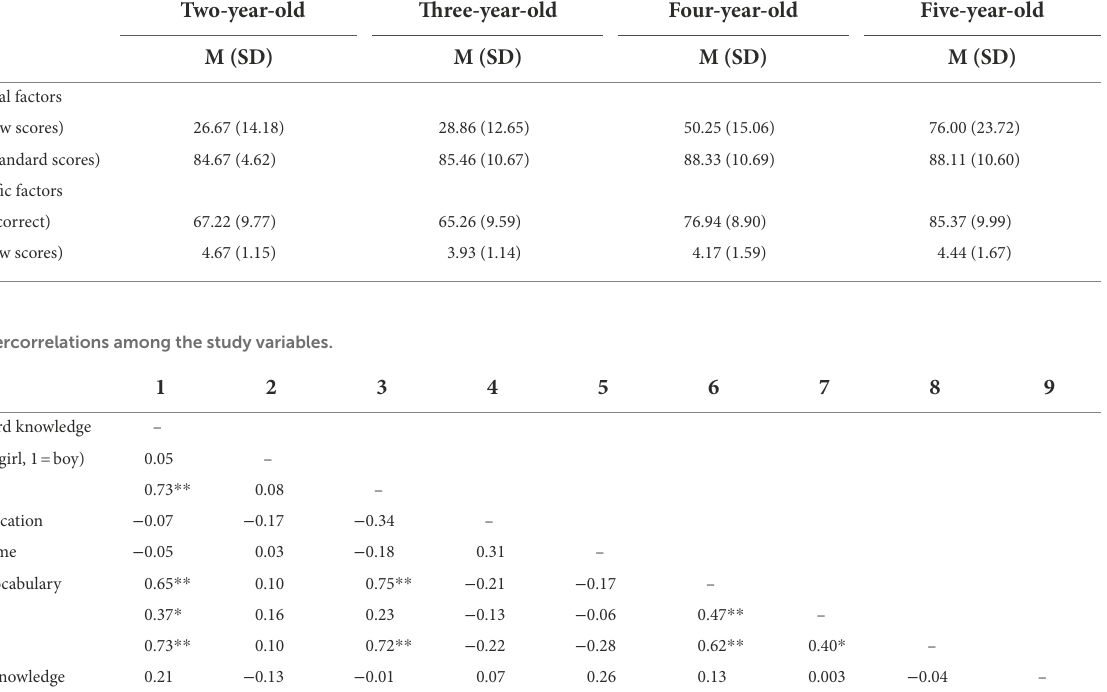
TABLE 4 Summary of descriptive statistics of performance scores on domain-general and domain-specific tasks for each age group.